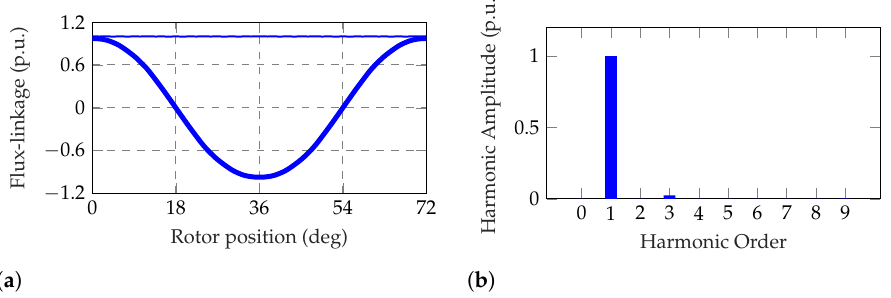
Figure 19. No-load flux-linkage waveform and harmonic content of the 12/10 spoke-type IPM motor. ( a ) Flux-linkage waveform. ( b ) Harmonic